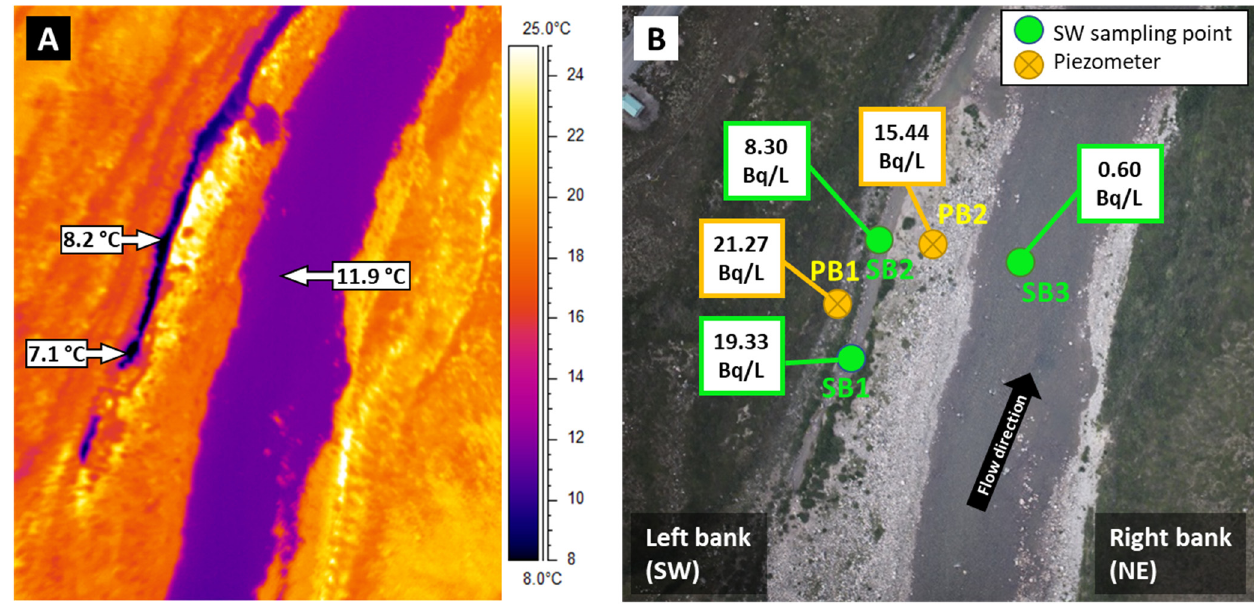
Figure 14. Water temperature of the side channel and main stem from TIR imaging ( A ) and radon concentration in Berard River piezometers and SW ( B ).